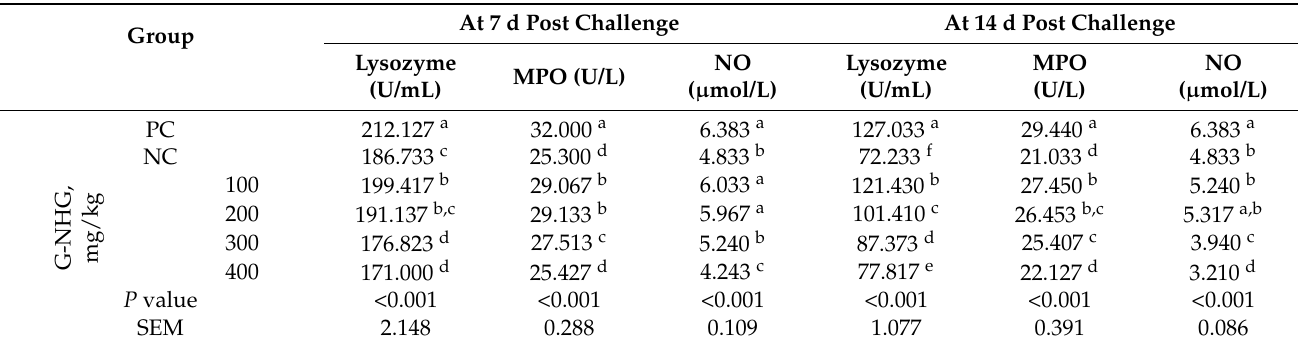
Table 4. Effect of different dietary levels of G-NHG on broiler chickens’ serum immunological parameters at 7 and 14 d post challenge with C. perfringens.